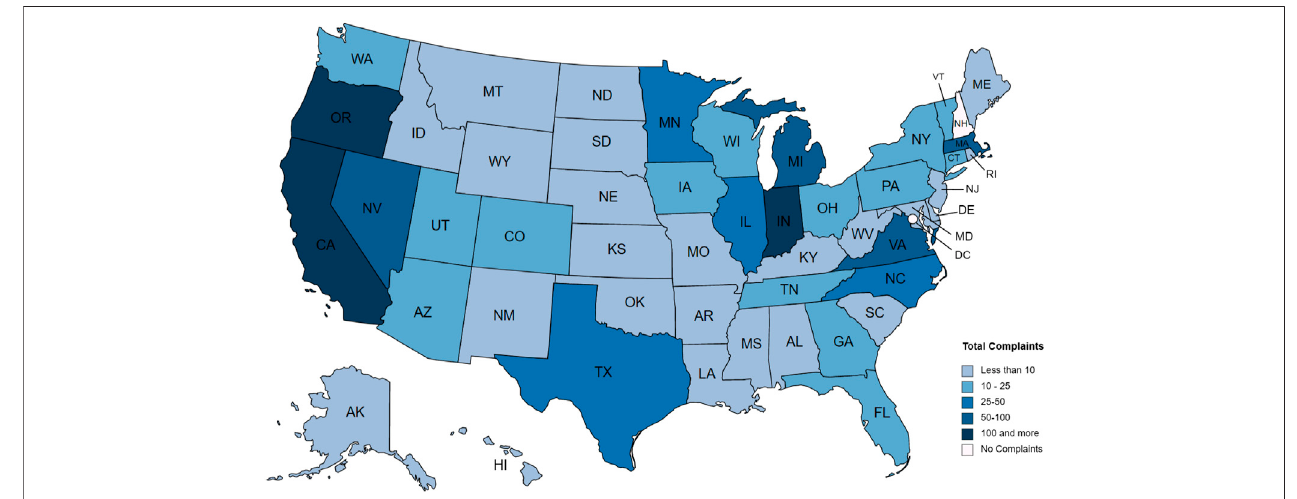
FIGURE 1 | Distribution of construction-related complaints across the states – generated by mapchart.net.